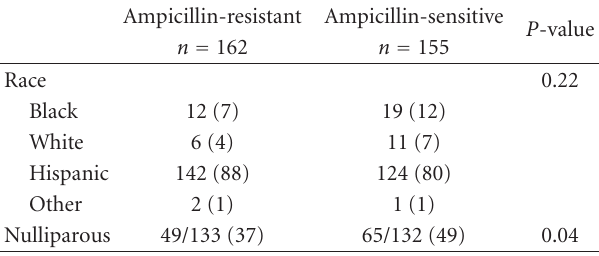
Table 2: Comparison of demographic characteristics of women with ampicillin-resistant versus ampicillin-sensitive uropathogens in acute antepartum pyelonephritis . Data are reported as n (%) or mean ± standard